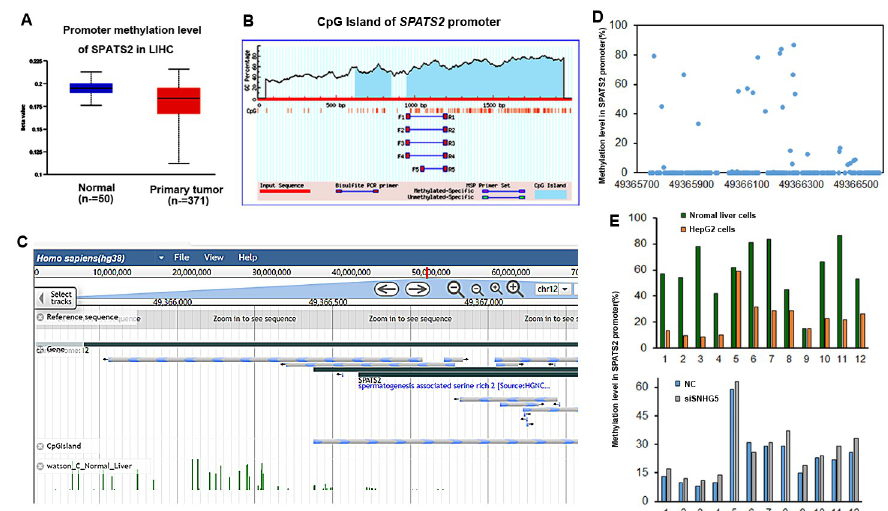
Fig 5. Expression of SPATS2 is associated with promoter methylation. (A) Hypomethylation of SPATS2 promoter in HCC tissues. (B) CpG Island of SPATS2 promoter region on the MethPrimer website. (C, D) Methylation level of SPATS2 promoter in normal liver cell. (E) Methylation level of SPATS2 in HepG2 and SNHG5 knockdown HepG2 cells.